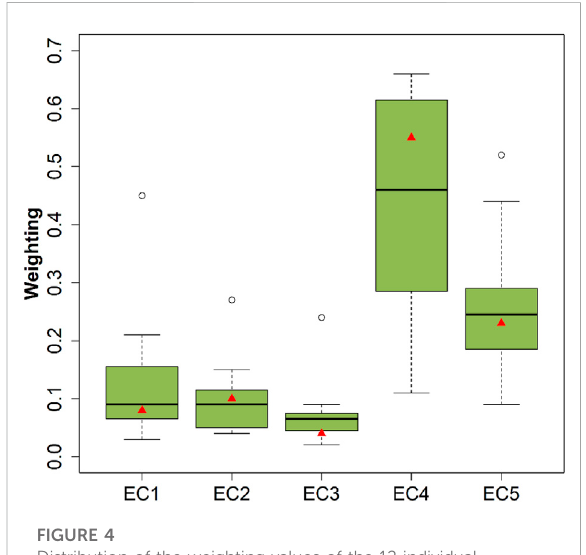
FIGURE 4 Distribution of the weighting values of the 12 individual stakeholders for each of the ecological criteria (EC1: Protected areas, EC2: Faunal diversity, EC 3: Functional diversity, EC4: Remaining grassland area, and EC5: Supporting and regulating ecosystem services supply). In each box, the horizontal black line represents the median, the extremes the quartiles (q1 and q3), the whiskers correspond to 1.5 of the interquartile range and the empty points are outliers. The red triangles represent the weights of the consensus